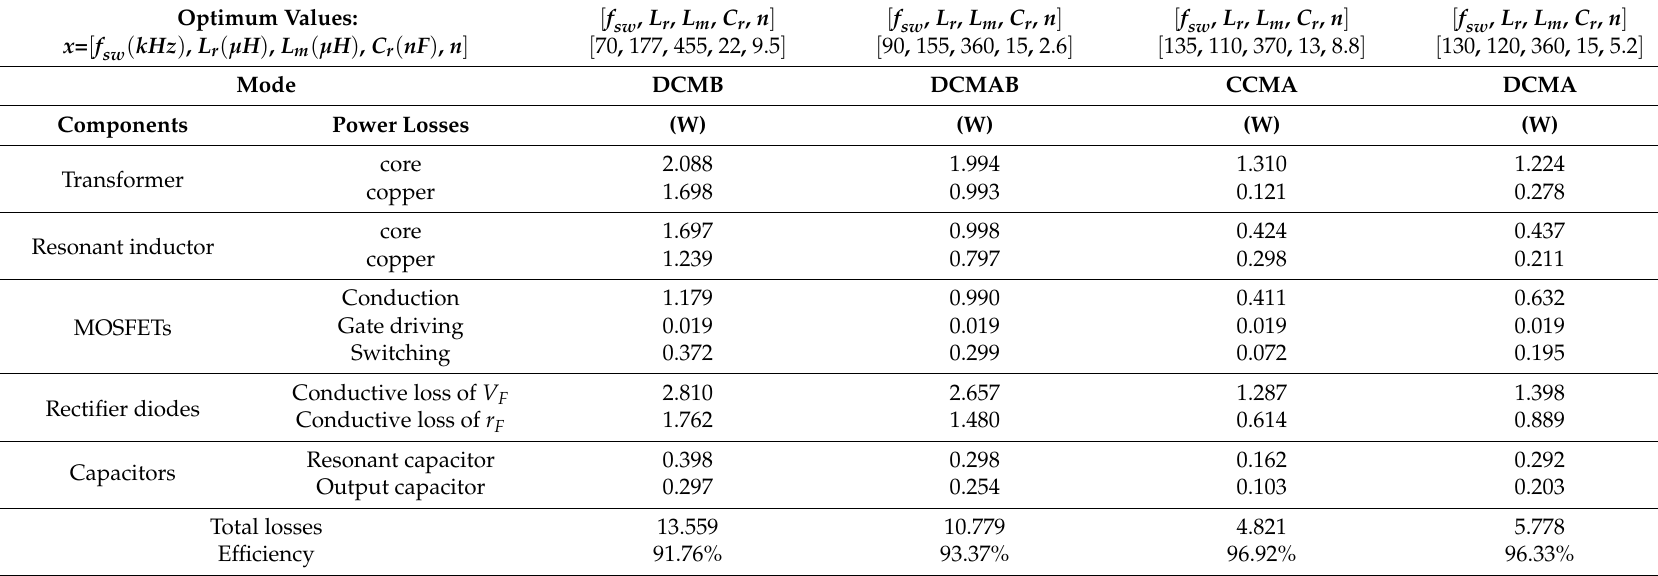
Table 7. Losses Profile of LLC resonant converter by modified LSQ optimization